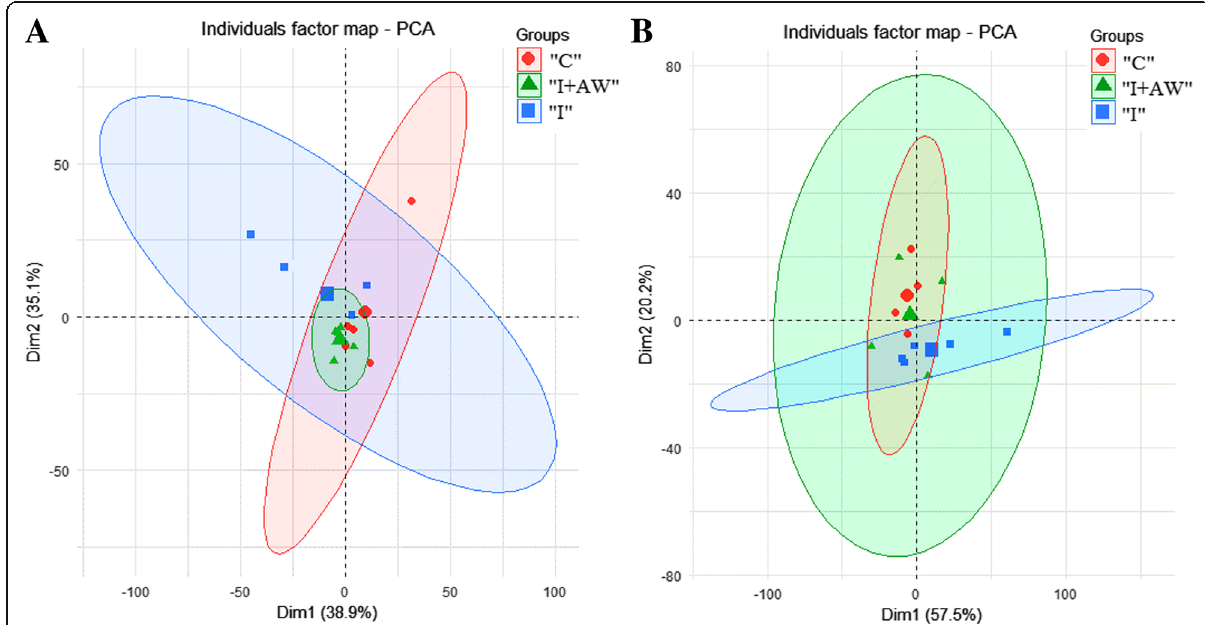
Fig. 7 The PCA score plots discriminating ( a ) serum and ( b ) tissue samples comparing “ C-I ” and “ I-I + AW ” groups. The C and I + AW samples are clustered very close to each other which means the treatment was successful. ( “ C ” : control group, “ I ” : rats with indomethacin-induced gastric ulcer, “ I + AW ” : ulcerated rats treated with AW extract)